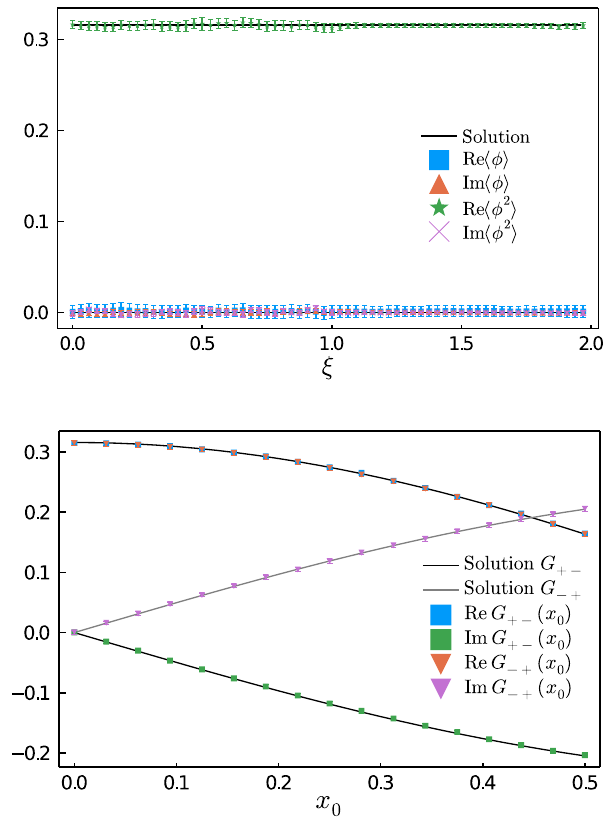
Figure 7 . (top) The field expectation value h φ i (box and triangle), as well as the equal-time correlation function h φ 2 i (filled star and cross) evaluated in thermal equilibrium along the whole simulation contour, parametrized by ξ . The continuous Langevin time solution from matrix me- chanics is given as solid line. (bottom) The phenomenologically relevant forward G + − = G > and backward G − + = G < correlation functions. Note that only in the thermal setting the information they contain is redundant with that of the G ++